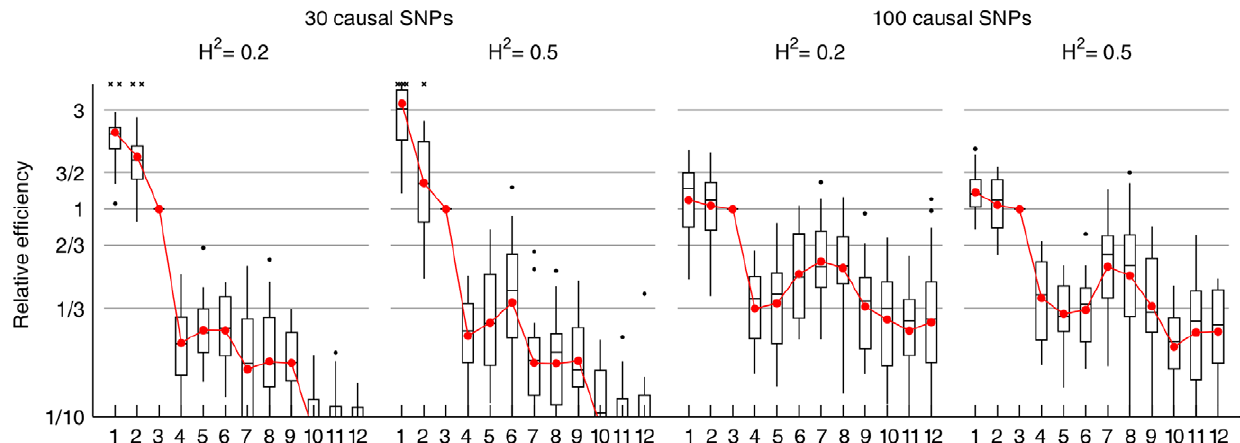
Figure 3. Relative efficiencies of the samplers in the simulated datasets. The boxplots show ESS/time values normalized to the third sampler, where the ESSs are computed for the c samples. Red dots show the geometric mean over the 20 datasets. Some outliers were truncated to fit into the figure and are shown with crosses. 1=adaptive MS-DR, 2=adaptive MS, 3=adaptive SS, 4=non-adaptive MS-DR, 5=non-adaptive MS, 6=non-adaptive SS, 7=NK10, 8=NK05, 9=NK01, 10=KSC10, 11=KSC05,